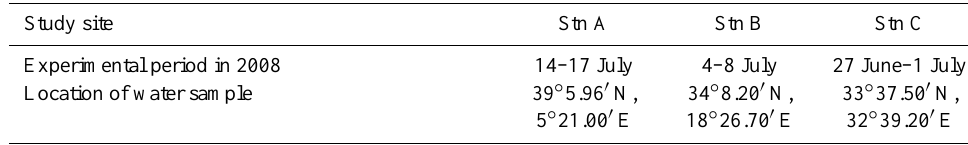
Table 1. Initial condition at the three sampling sites. Parameter values are shown as mean ± SD ( n = 3) except for water temperature and heterotrophic nanoflagellates ( n =